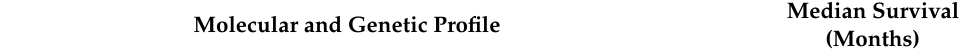
Table 2. Features of neural, proneural, classical, and mesenchymal GBM subtypes. GBM Subtype Molecular and Genetic Profile